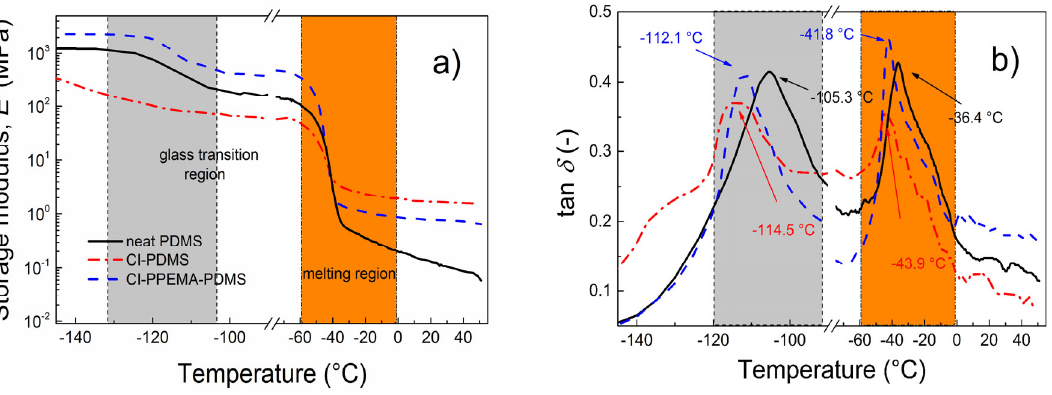
Figure 6. Temperature dependence of the tensile storage modulus, E’ ( a ) and damping factor, tan δ ( b ) for the neat PDMS matrix ( black solid lines ), the isotropic SE containing bare CI ( red dash/dot lines ), and CI-PPEMA ( blue dashed lines ) particles. The grey and orange region represent glass transition and melting, respectively.